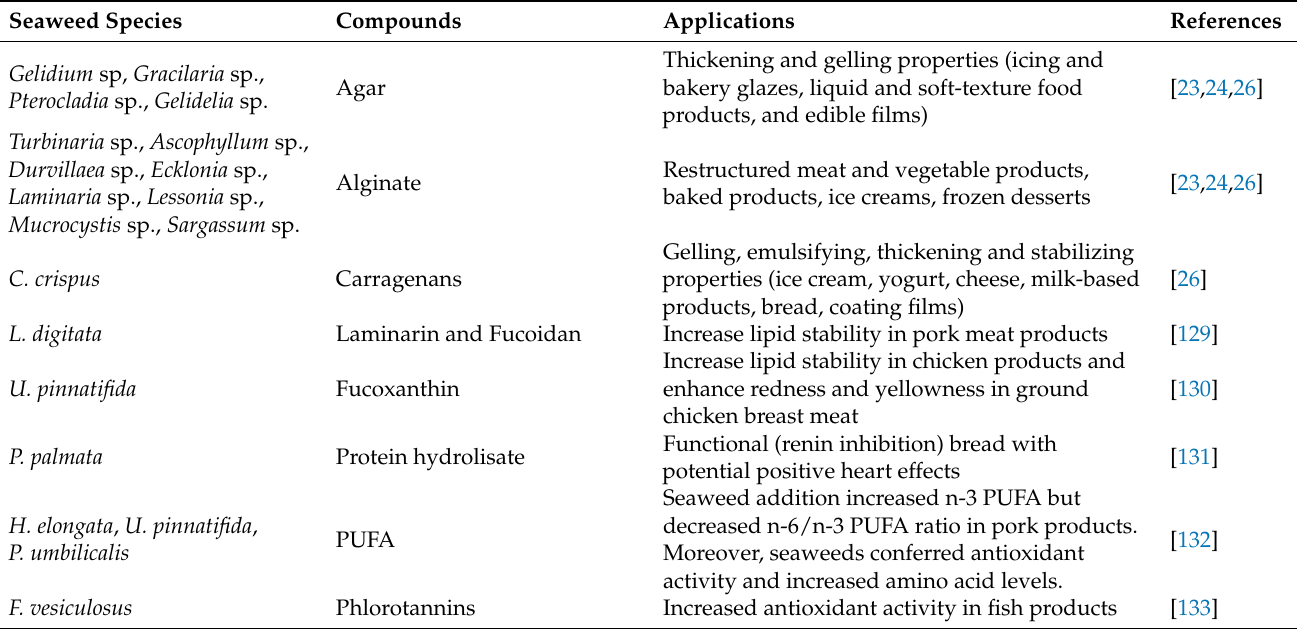
Table 2. Food applications of seaweeds